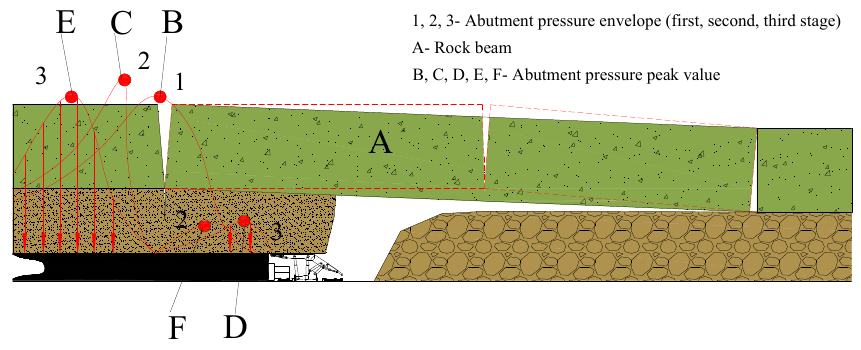
Figure 2. The forming process of internal and external stress field.